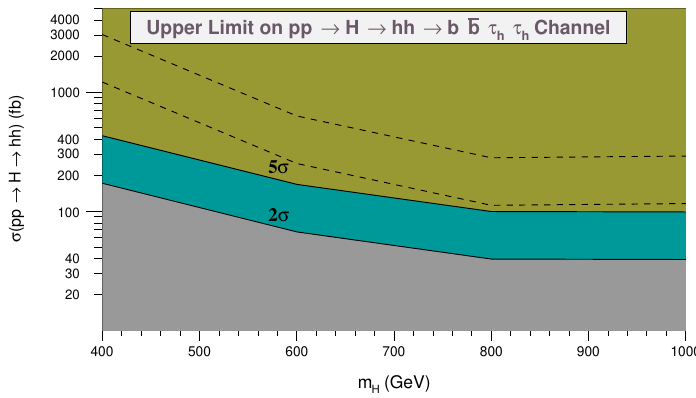
Figure 16 . Upper limit on (cid:27) ( pp The solid (dashed) lines show the 2 (cid:27) -5 (cid:27) band on taking 0% (5%) systematic uncertainties.